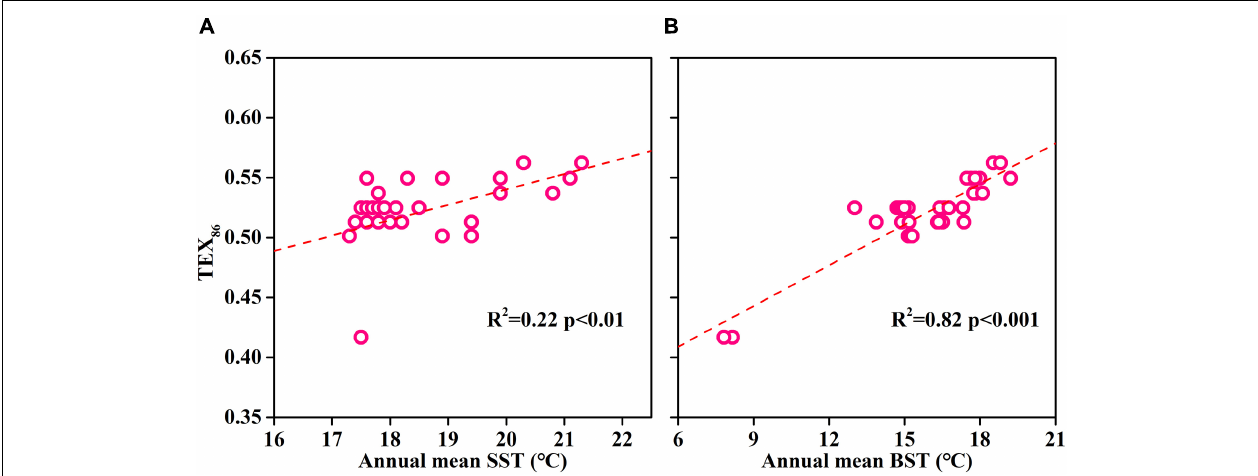
FIGURE 8 | The relationships between sedimentary TEX 86 and annual mean surface seawater temperature (SST) (A) and bottom seawater temperature (BST) in the East China Sea (B) . Surface sediment data were obtained from Lü et al. (2014). Annual mean seawater temperature data were obtained from NOAA website (WOA13; https://www.nodc.noaa.gov/).